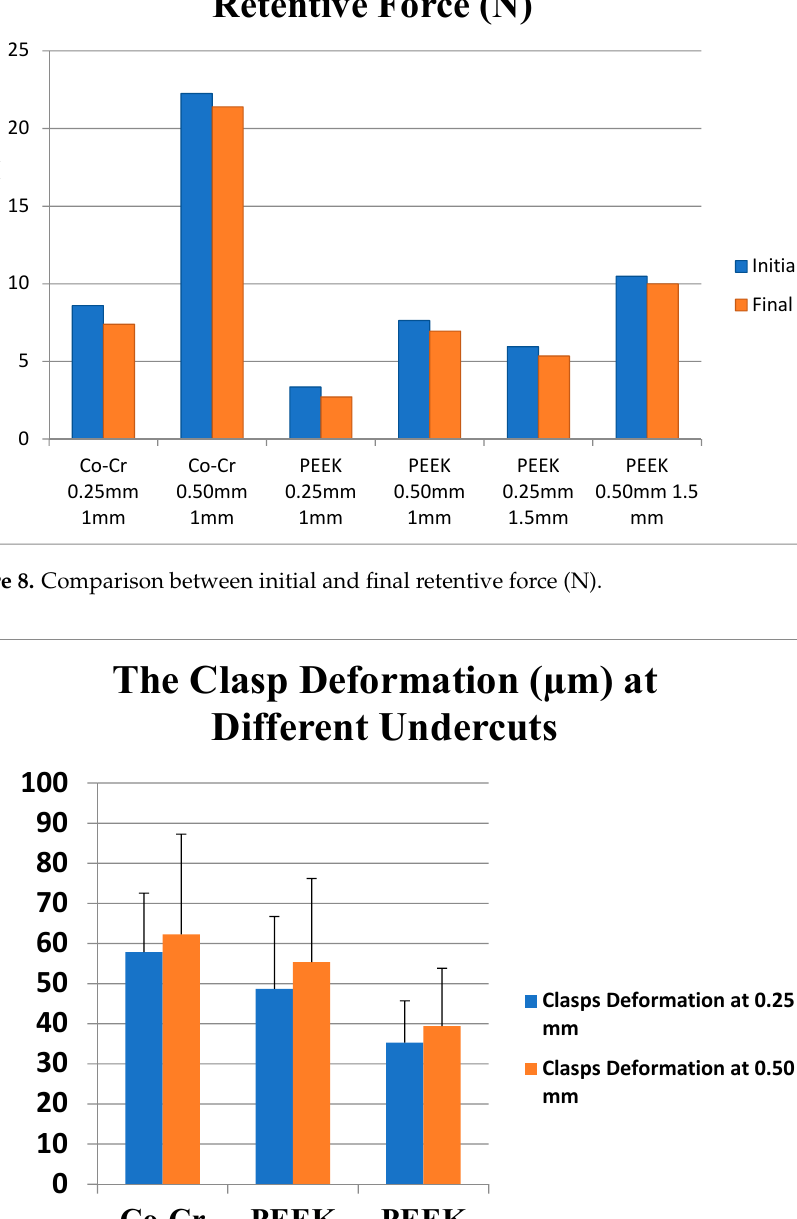
Table 4 . The mean deformation of clasps (µm).